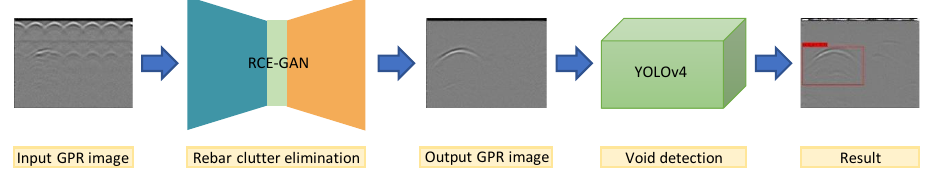
Figure 1. Workflow of the proposed